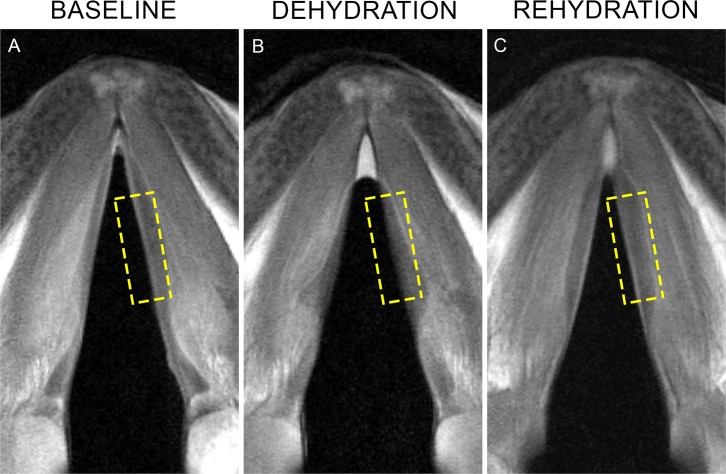
PD-MRI image of porcine vocal fold.Representative images of slices through vocal fold of the same larynx. (A): Baseline. (B): After dehydration in 30% NaCl. (C): After rehydration in H2O. Dashed boxes highlight mucosa at the vocal fold edge.